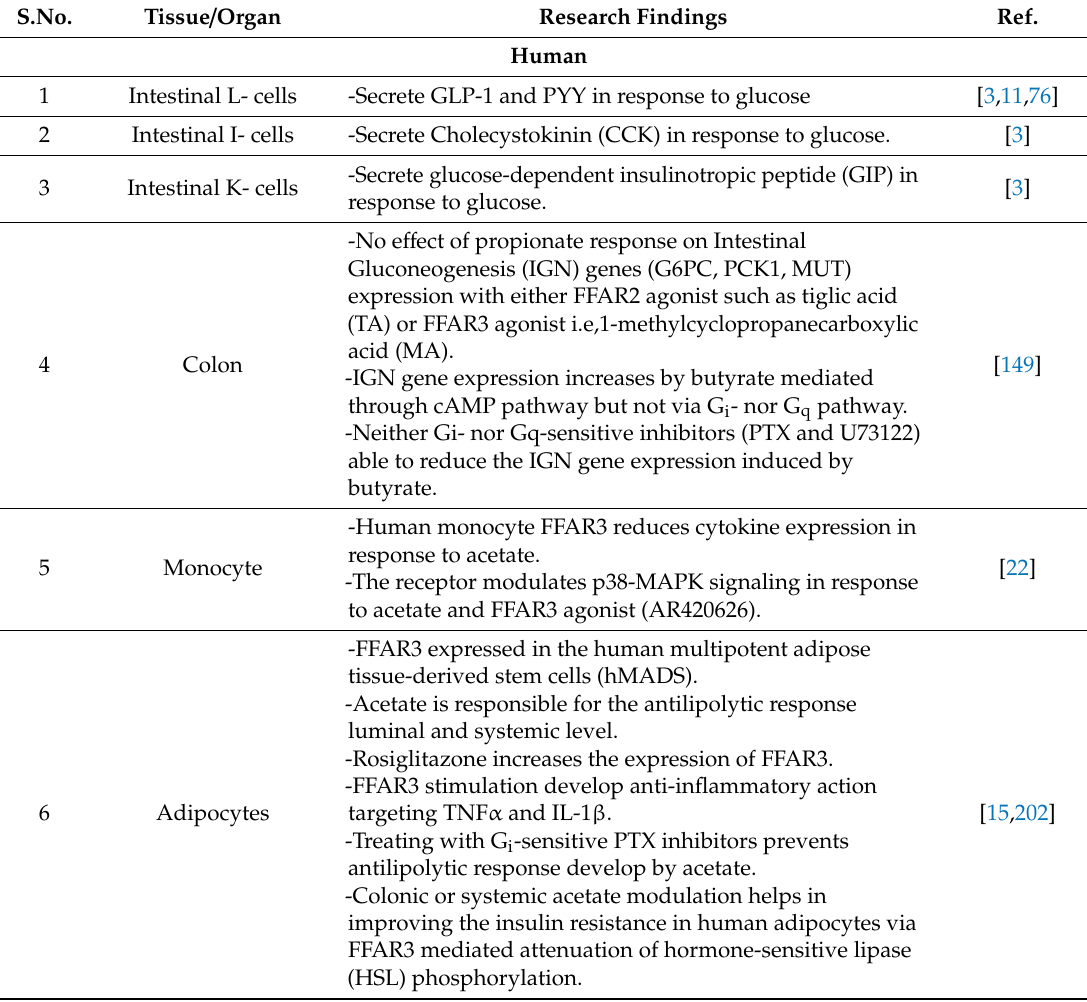
Table 3. Physiological function of FFAR3 in humans and mice /